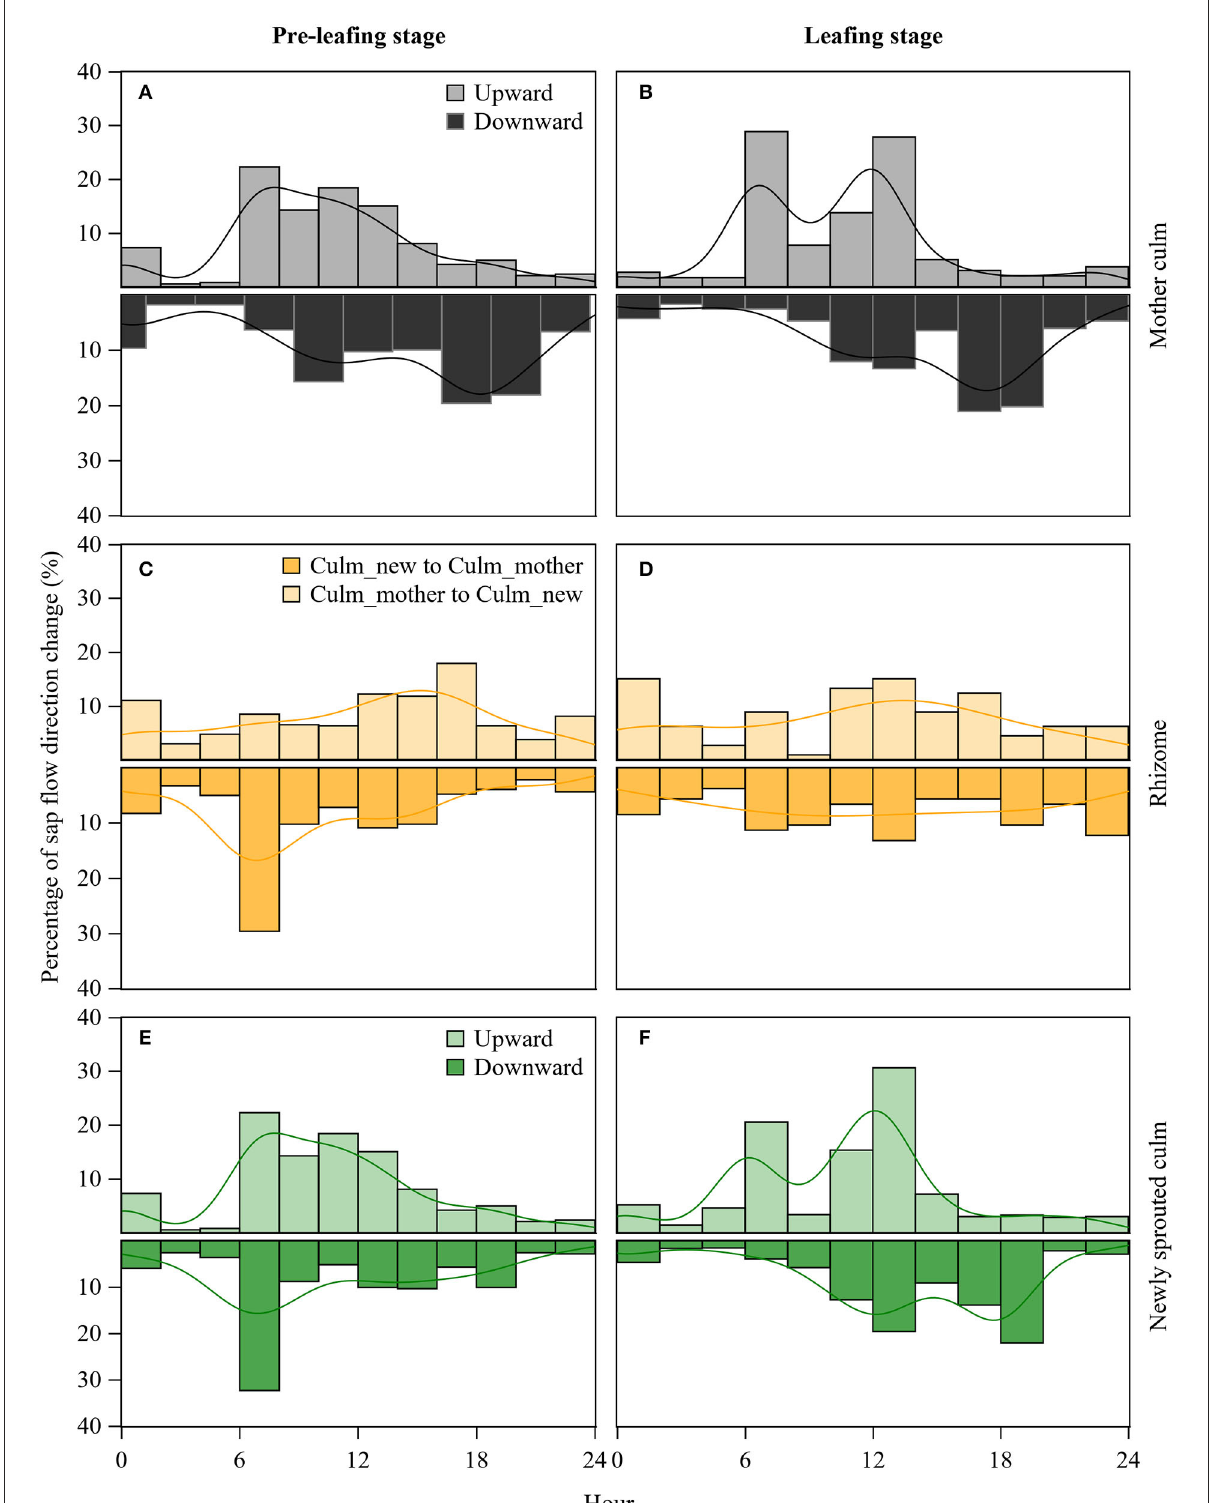
FIGURE5 Probabilities at which hours when there was a change in the sap flow direction in rhizomes (C,D) , stems of both mother (A,B) , and newly sprouted (E,F) culms at the pre-leafing and leafing stages of newly sprouted culms.